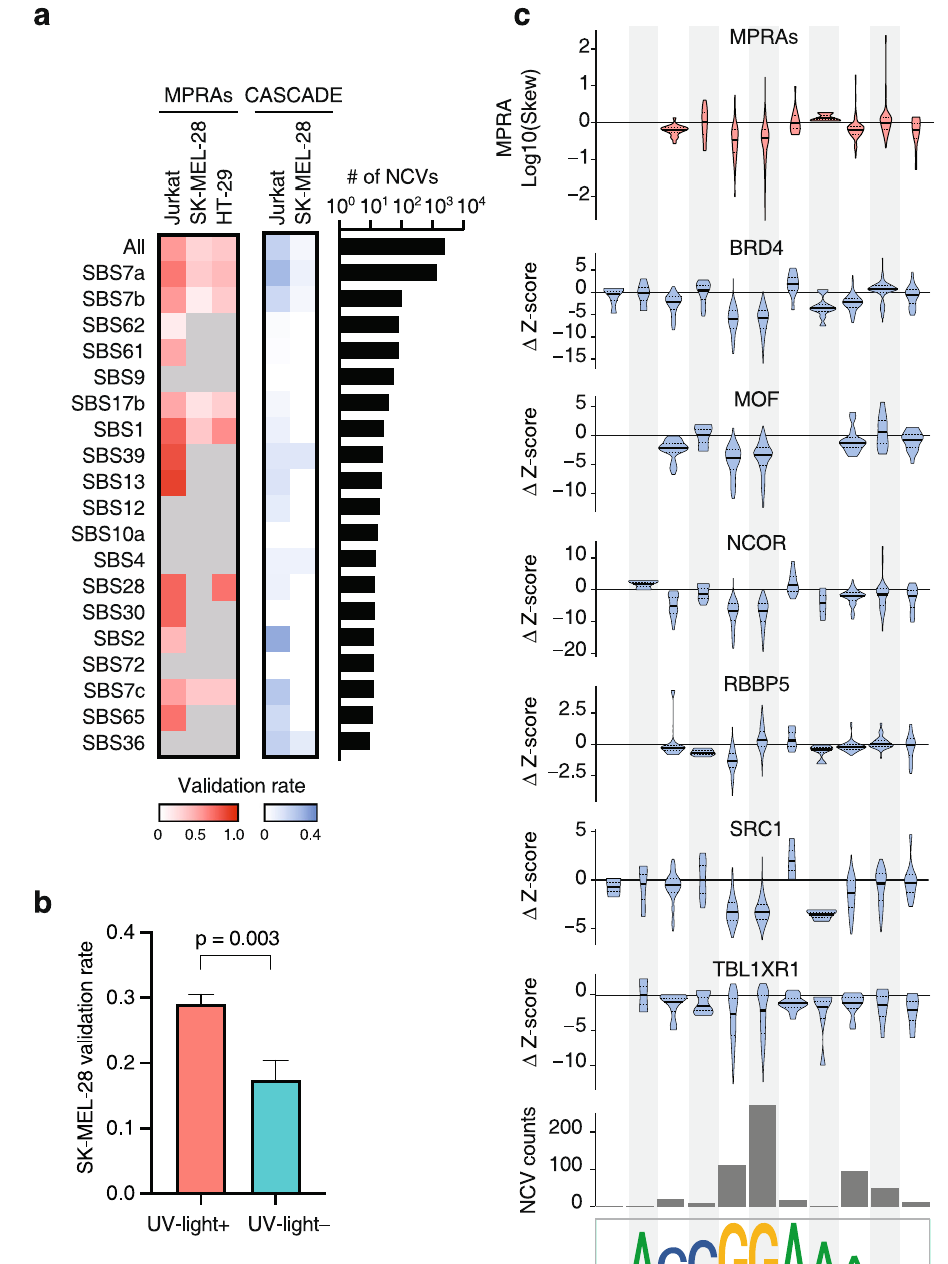
Signi fi cance determined by two-sided Fisher ’ s exact test. c Mutational frequency andeffectontranscriptionalactivityandCOFbindingforskincancerTFA-BTNCVs dependingonthepositionwithintheETSmotif.Thetopviolinplotshowsthelog 10 expression allelic skew by MPRA for NCVs affecting different positions within ETS motifs. The bottom six violin plots show the Δ z-score in COF binding between the referenceandthealternativeallelebasedonthepositionoftheNCVwithintheETS motif. The median is indicated by the bold horizontal line, and the fi rst and third quartiles are indicated by the dotted horizontal lines. The bar plot indicates the number of TFA-BT NCVs affecting each position in the ETS motif. Source data are provided as a Source Data fi